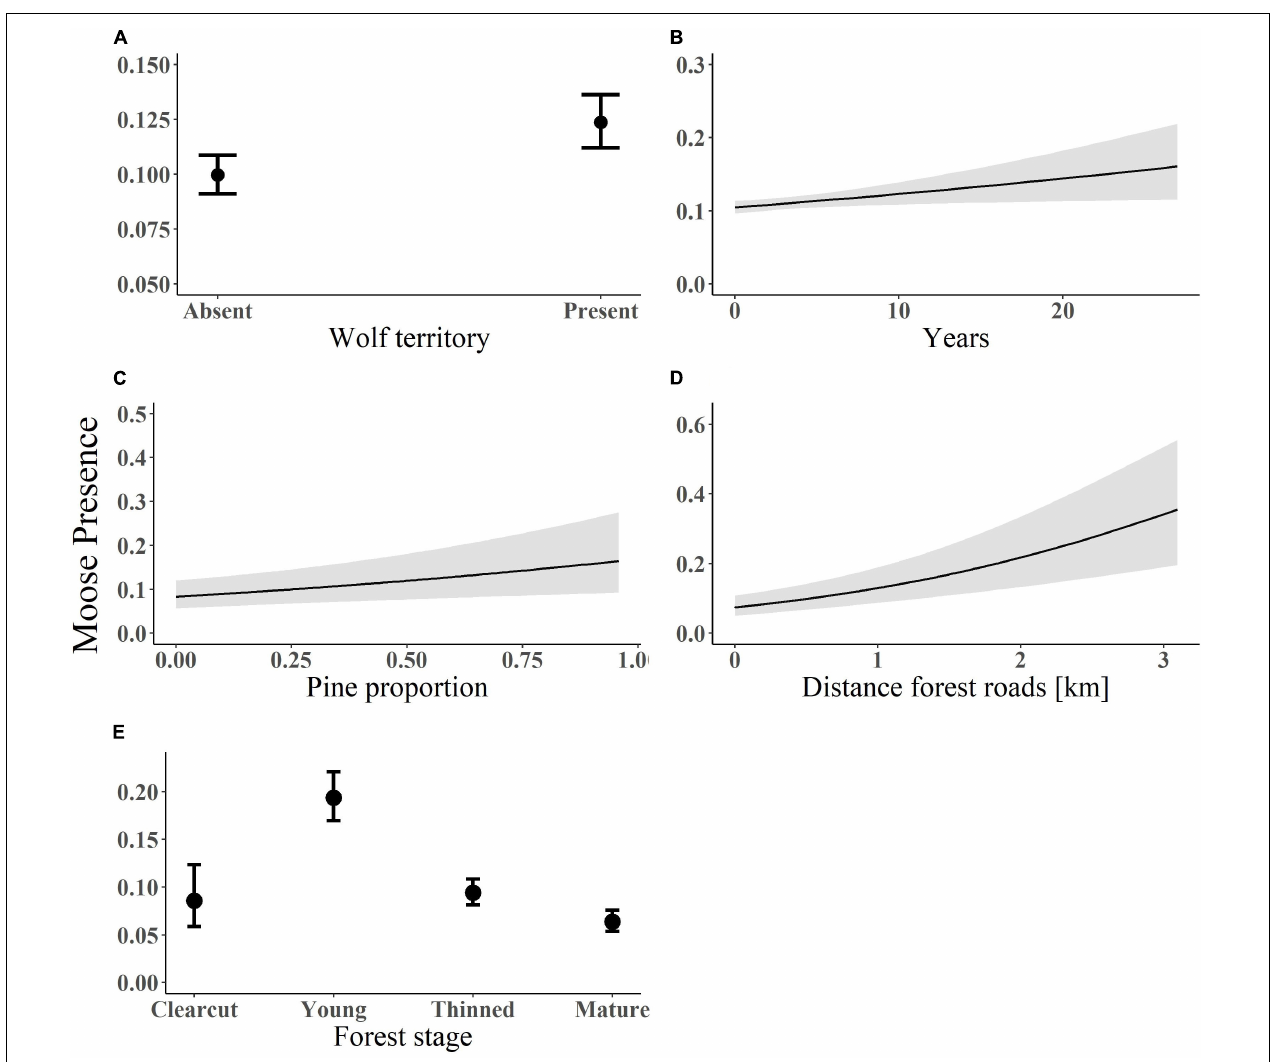
FIGURE 1 | Predicted probability of moose presence in relation to (A) wolf presence; (B) years since wolf territory establishment; (C) pine proportion; (D) distance from forest roads; and (E) forest age stage. Data on moose presence was recorded in south-central Sweden between 2003 and 2016. The lines (in plot B–D ) represent the fitted values and associated standard errors from the model-averaged estimates. Plot a and e show the coefficients and confidence intervals of the predicted probability of moose presence in relation to the presence/absence of a wolf territory (A) and across four forest age stages (E) .